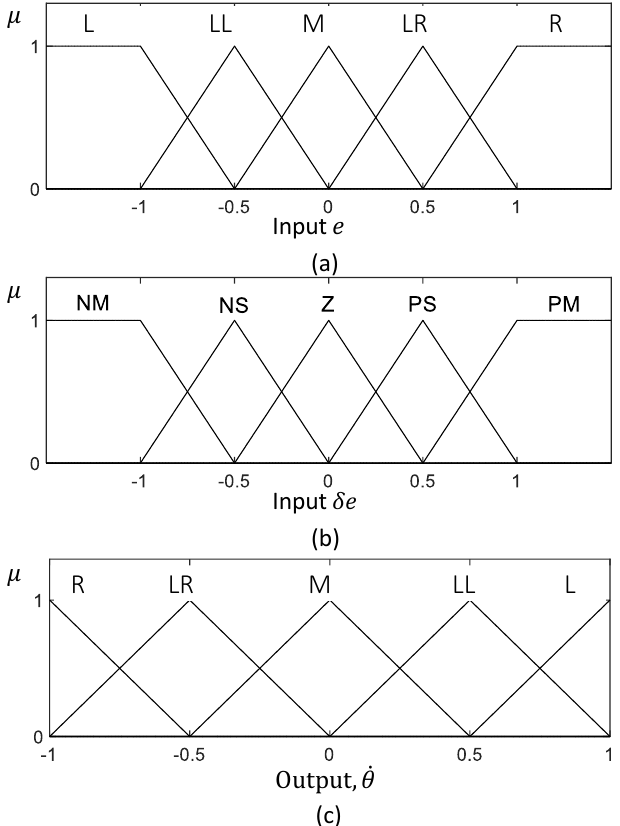
Figure 10. Input and output membership functions of fuzzy inference system. ( a , b ) The input membership functions. ( c ) The output membership function.The fuzzy labels are defined as R: Right, LR: Little Right, M: Middle, LL: Little Left, L: Left, NM: Negative Medium, NS: Negative Small, Z: Zero, PS: Positive Small, and PM: Positive Medium. It should be noted that the membership functions are given in normalized scales.